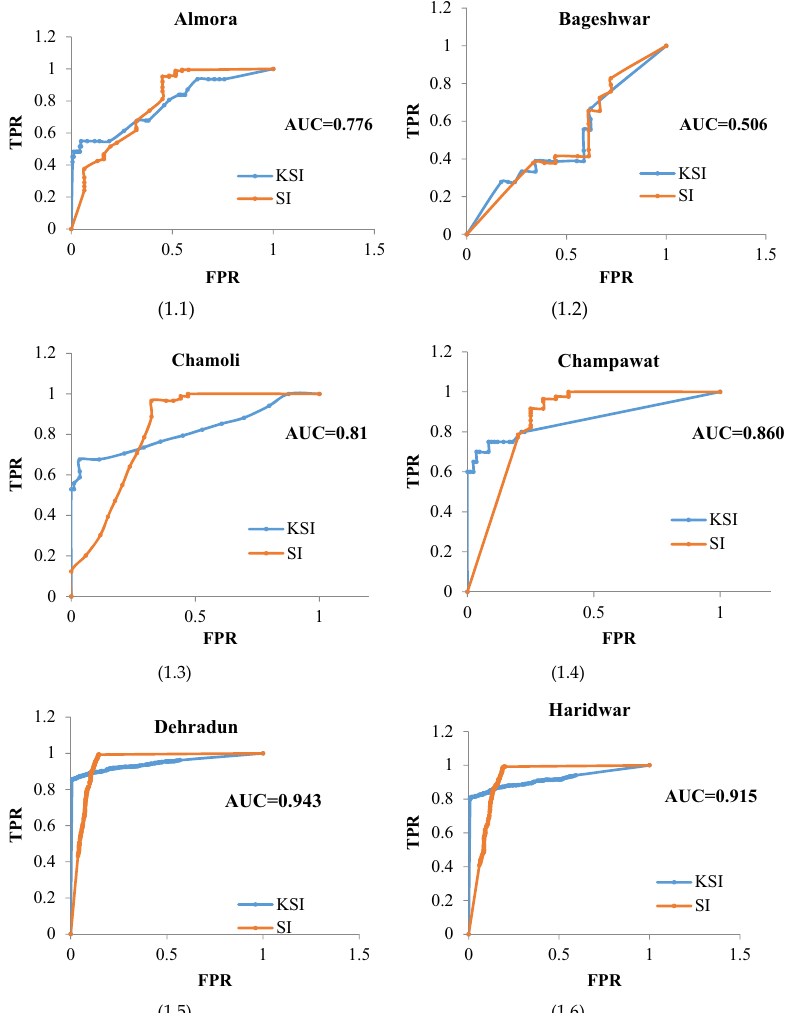
Fig. 2 ROC plot to illustrate the performance of decision tree classifier on 13 districts and EDS, ROC plot for all districts is shown in 2.1 to 2.13 and for EDS in